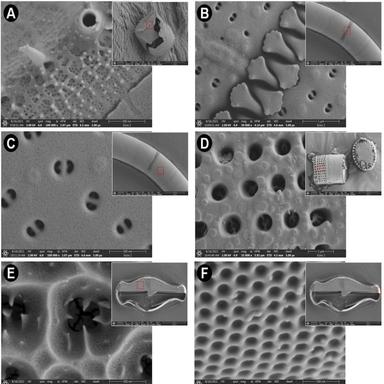
SEM images of characteristic features of (A) Stephanodiscus parvus (Biebrza river, Poland) (B-C) Aulacoseira cf. islandica (Okmin Lake, Poland), (D) Aulacoseira sp. (diatomaceous earth, DIATOMIT, Perma Guard), (E-F) Didymosphenia geminata (Wisloka river, Poland). Inputs: SEM images of the whole frustules with the designated places of the observations.